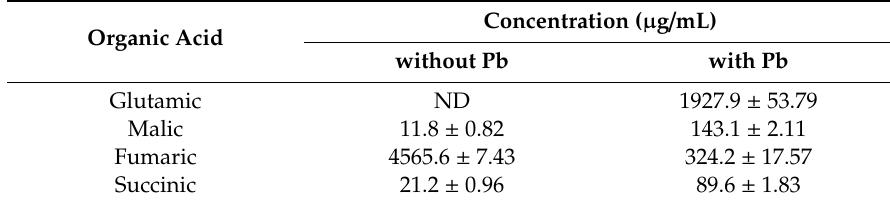
Table 5. Organic acids produced by strain H21 in the presence or absence of lead in PDB (Potato Dextrose Broth) medium.